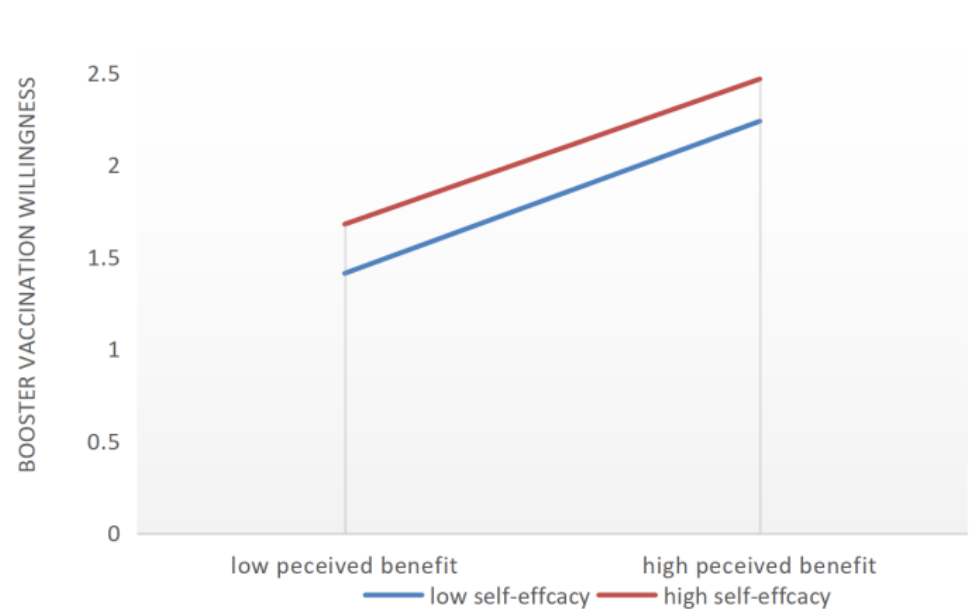
Figure 2. The moderating effects of self-efficacy on the relationship between perceived benefits and booster vaccination intentions.